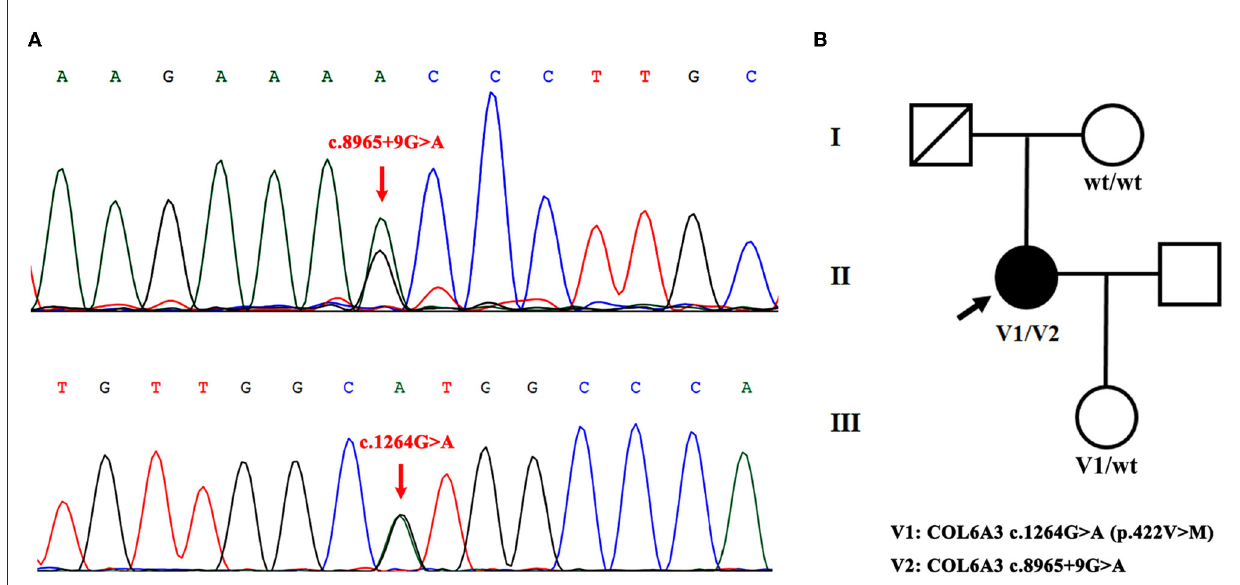
FIGURE1 Novel compound heterozygous mutation of COL6A3 in patient S10. (A) Sanger sequencing chromatograms of portions of COL6A3 gene compound mutation (c.8965 + 9G > A and c.1264G > A) (red arrowed) in patient S10. (B) Family pedigree chart of patient S10 (V1/V2). The patient’s father has passed away, her mother did not have either of the two variants (wt/wt), and her daughter had the mutation of c.1264G > A